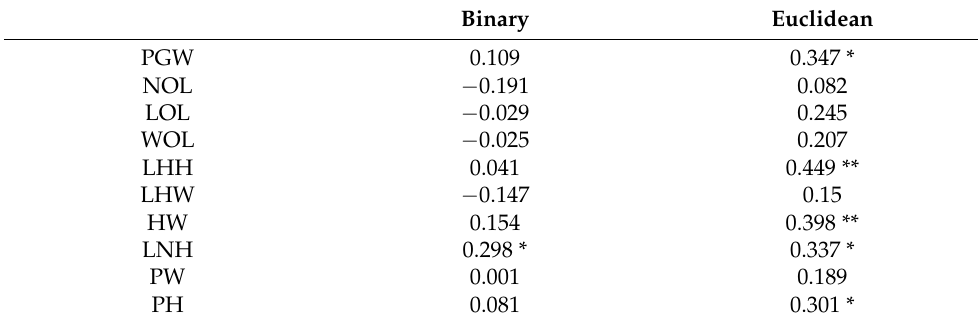
Table 5. Correlation between mid-parent heterosis value of traits and parents’ genetic distance. Binary Euclidean PGW 0.109 0.347 *